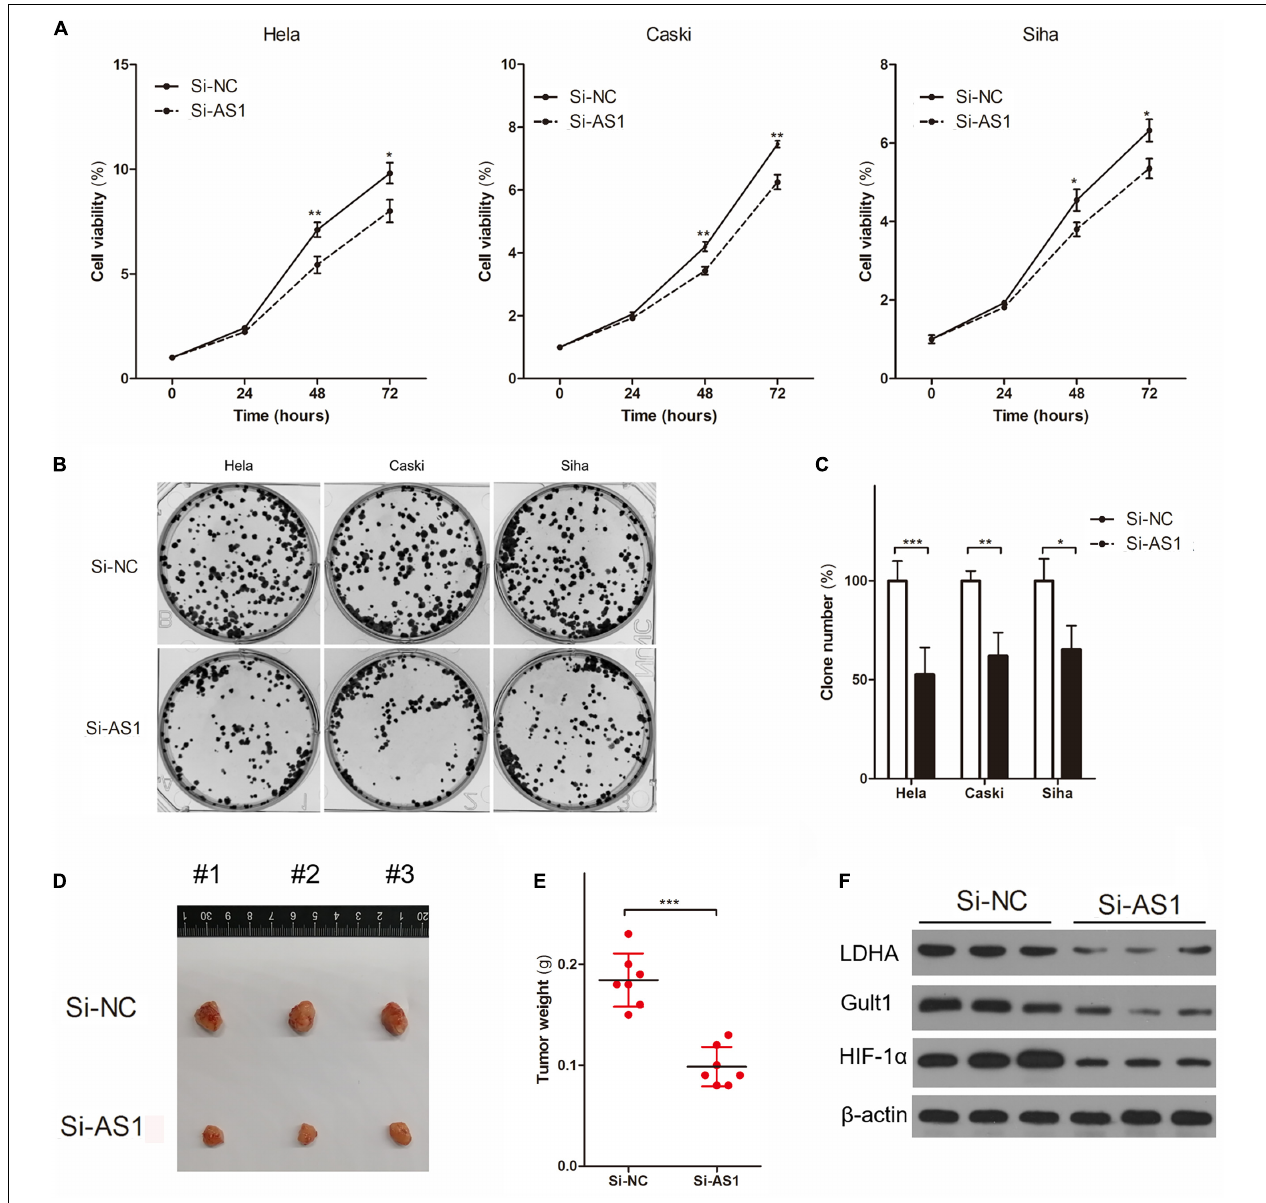
FIGURE 2 | OIP5-AS1 regulates the proliferation of cervical cancer cell in vivo and in vitro . (A–C) Cell viability (A) and cell clone number (B,C) were detected in Hela, Caski, and Siha cervical cancer cell knocking down OIP5-AS1. Data were shown as mean ± SD of three individual experiments. * was P < 0.05, ** was P < 0.01, and *** was P < 0.001, and P value was calculated by Student’s t test. (D,E) Representative of Hela cervical cancer cell xenograft tumors images are showed (D) and the xenograft tumors weight was compared (E) . Data were shown as mean ± SD. *** was P < 0.001, and P value was calculated by Student’s t